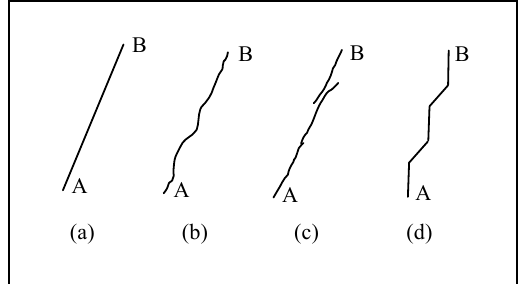
Figure 2. Different possibilities for line shape